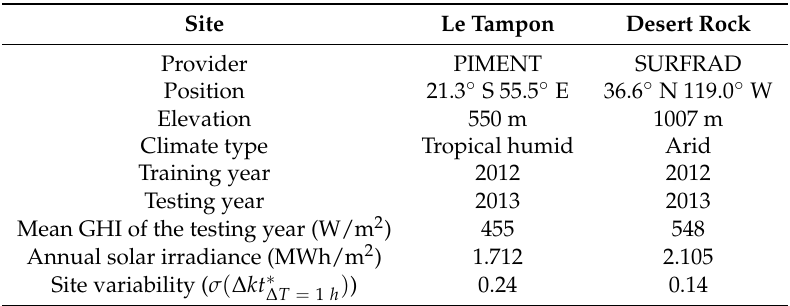
Table 1. Main characteristics of the two sites under study.